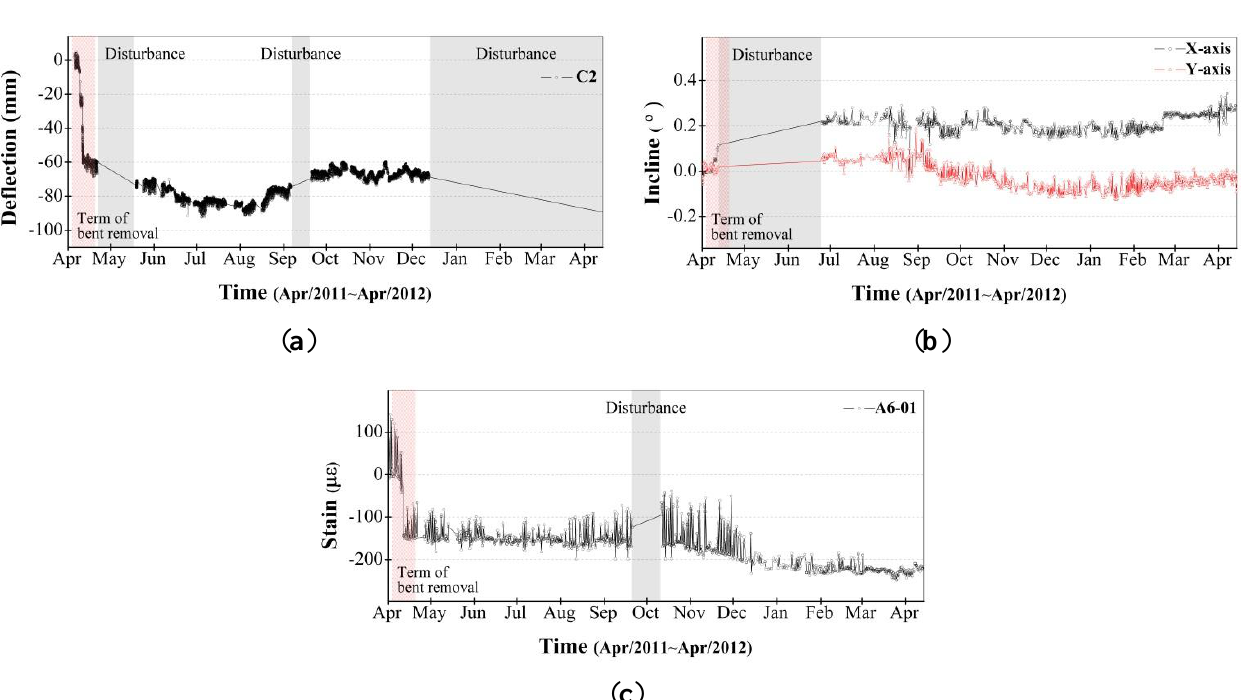
Figure 12. 13-month monitoring. ( a ) Deflection in zone C2 ( b ) Inclination in zone C3; ( c ) Strain data in zone